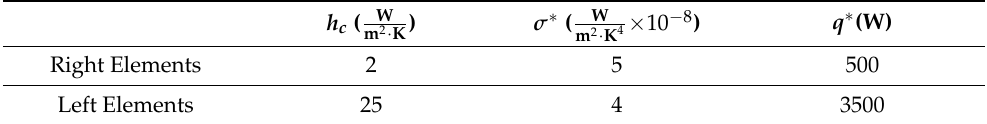
Table 5. The heat source, convection, and radiation characteristics are on both sides of the wall components in the case of a cross section of the wall.